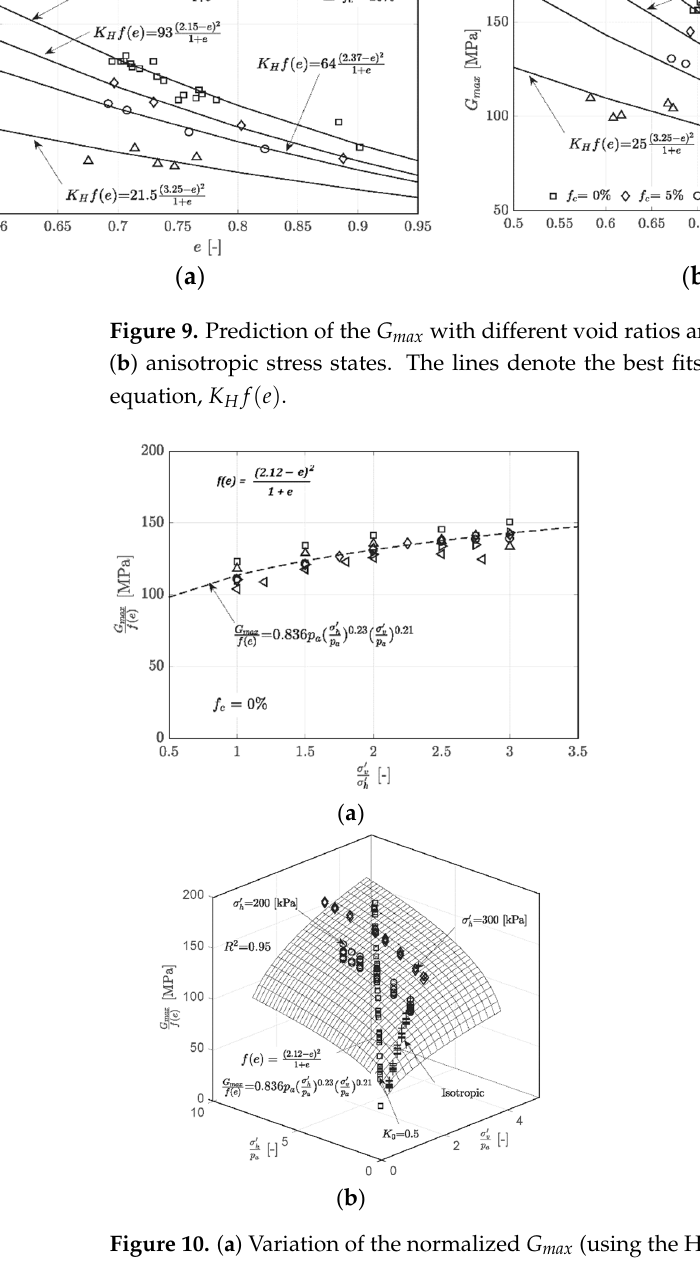
Figure 10. ( a ) Variation of the normalized G max (using the Hardin void ratio function) with the hori- zontal and vertical stresses accounting for both isotropic and anisotropic states; ( b ) 3D representation of the same (also shown in [39]).